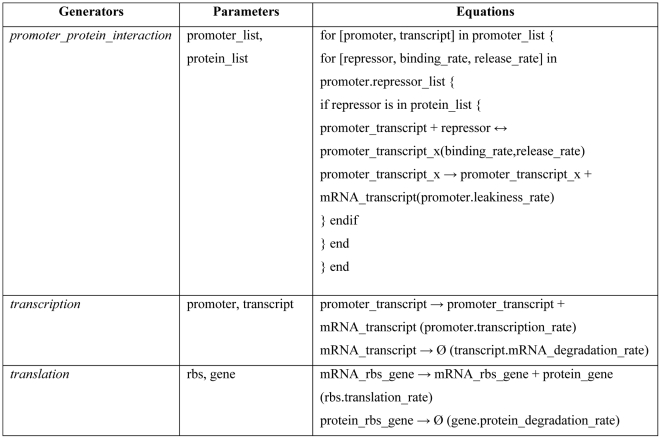
Equation generators.